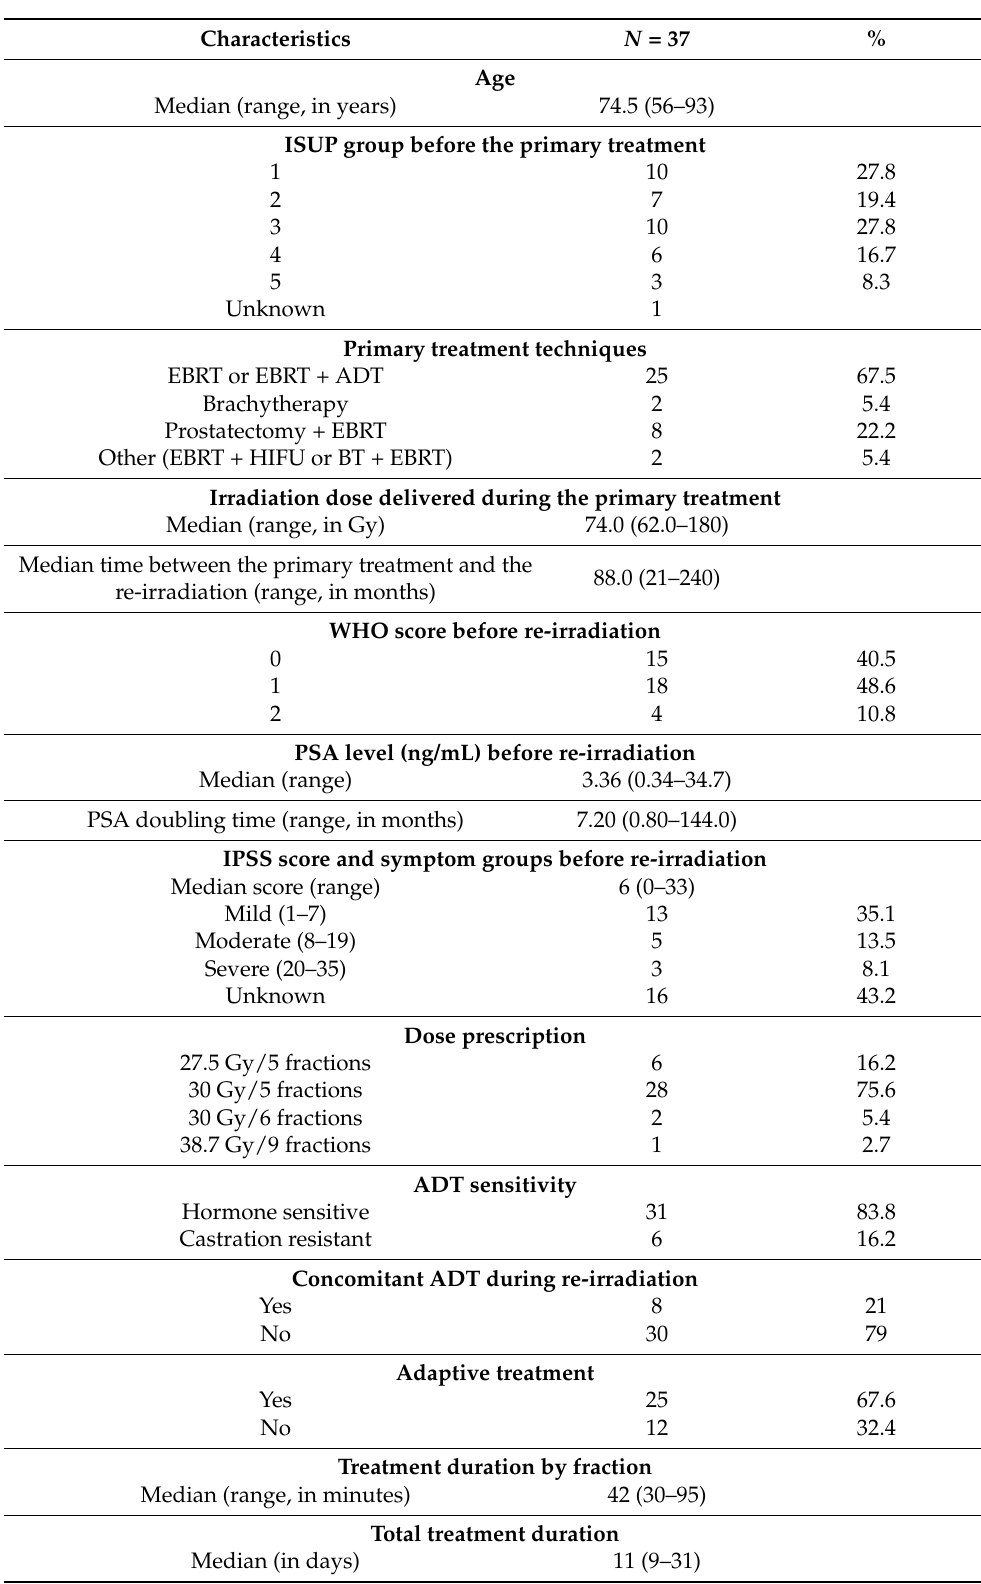
Table 1. Patient and treatment baseline